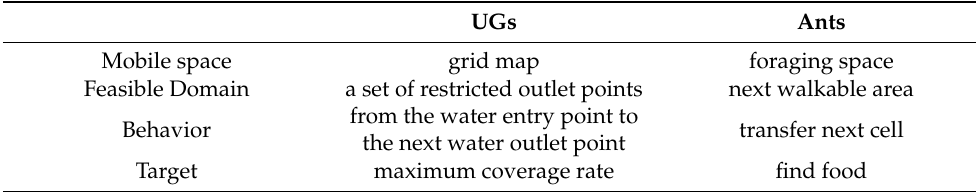
Table 1. The mapping relationship between UGs and ants. UGs Ants